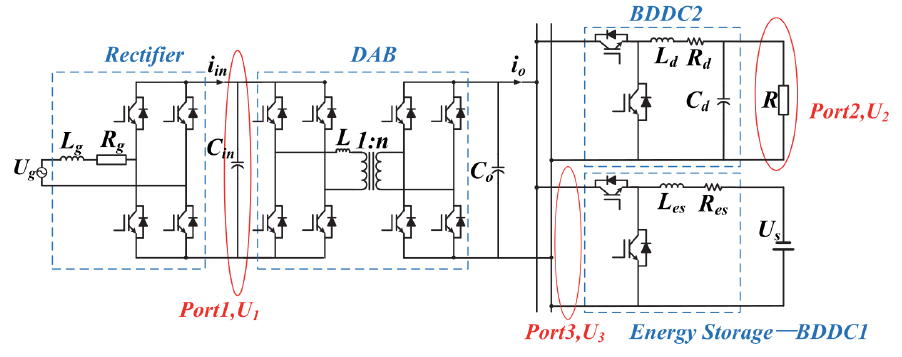
Figure 4. SST architecture studied in